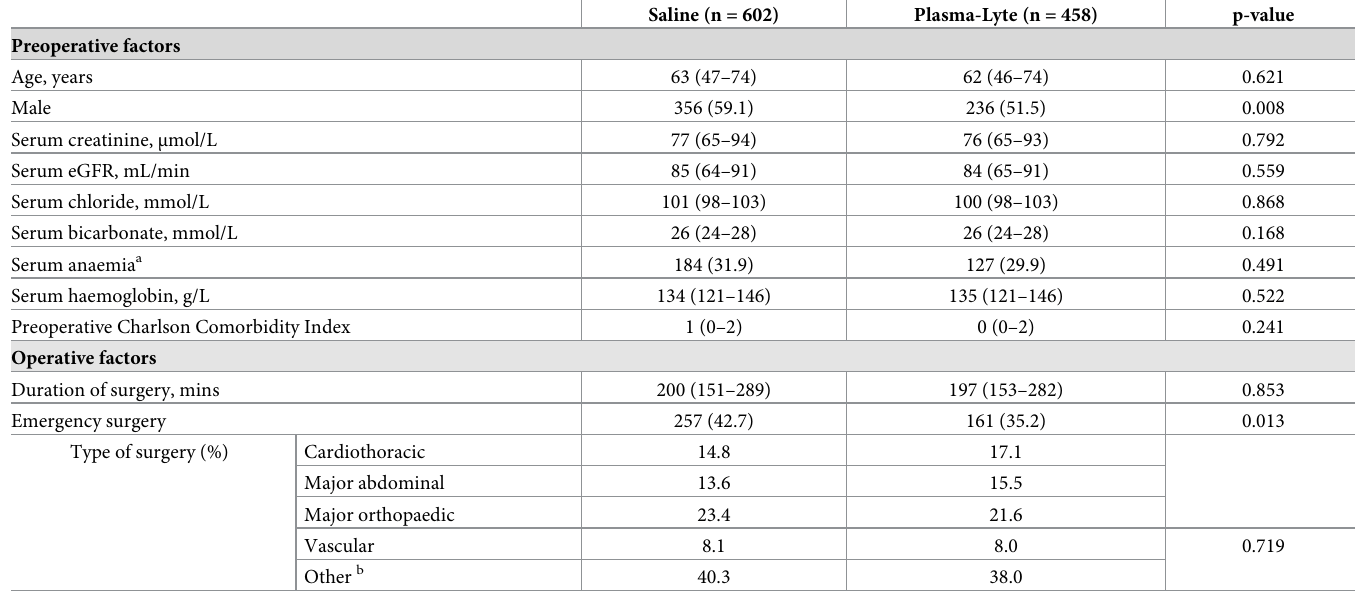
Table 1. Perioperative variables in patients receiving Saline and Plasma-Lyte. Data is median (interquartile range) or number